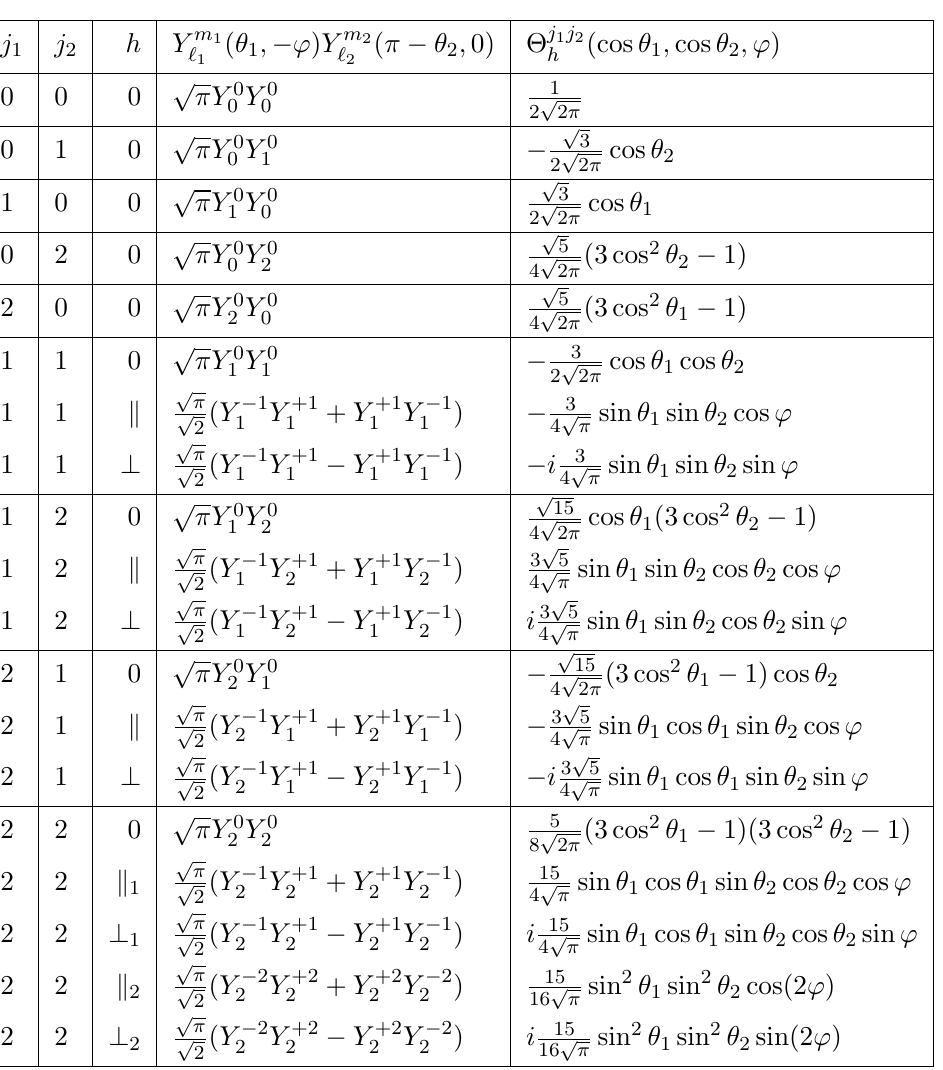
Table 6 . Functions containing the angular dependence of the amplitudes, as introduced in eq. (2.4). For a discussion on some of the angular terms see ref.